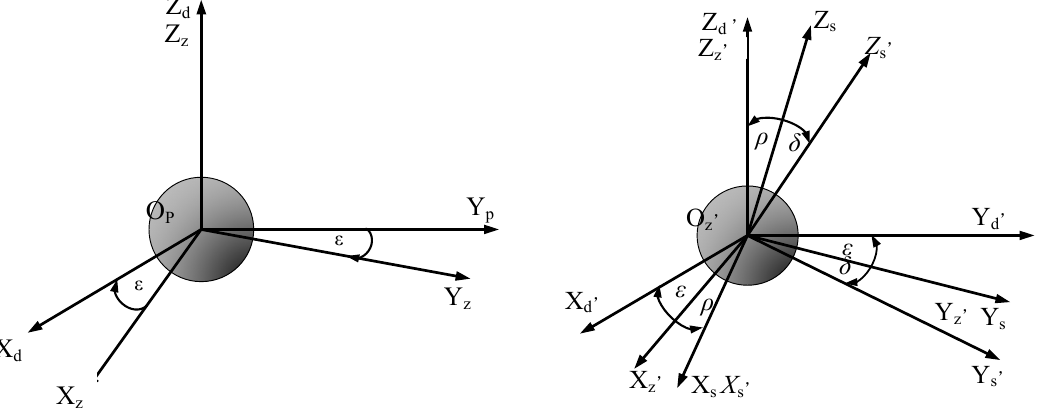
Figure 2. Transformation of coordinate system of ceramic ball motion.